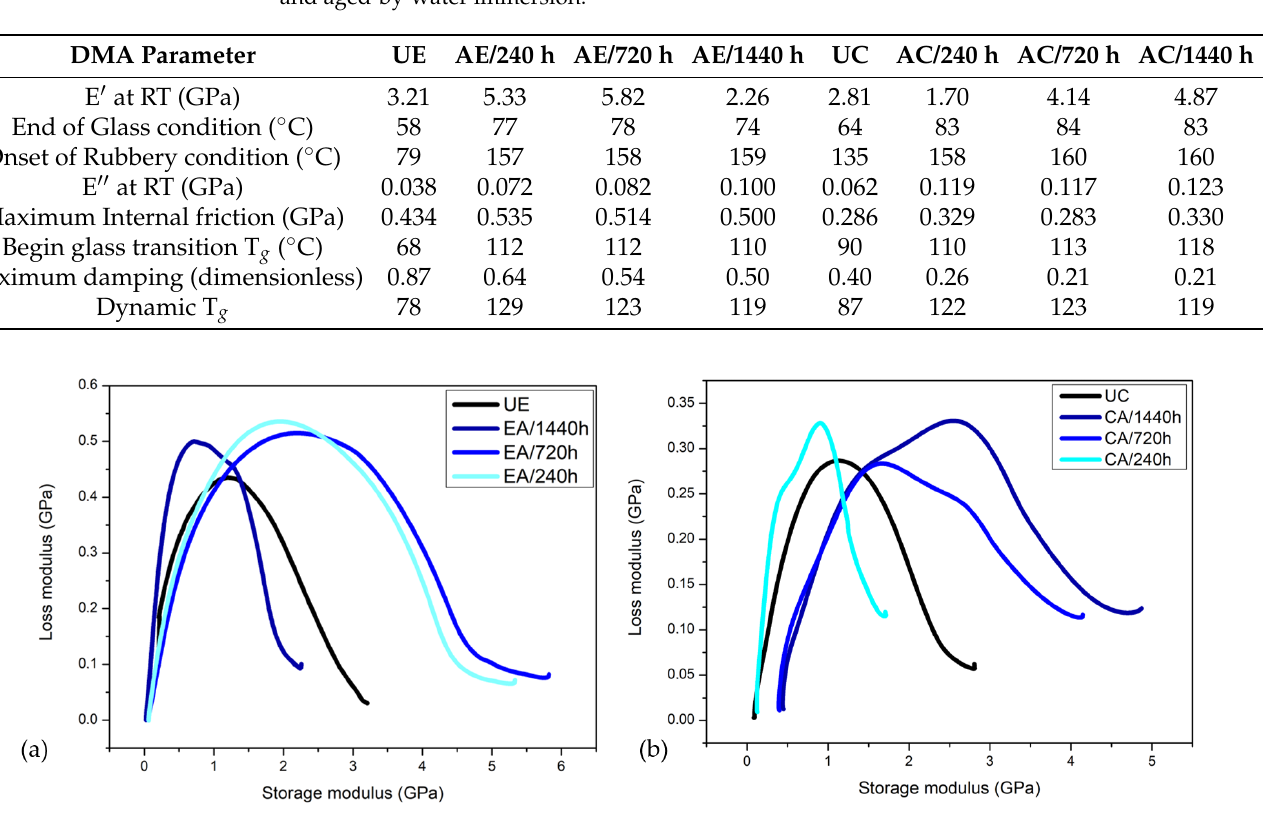
Figure 13. Cole–Cole plots of ( a ) the UE aged epoxy treatments and ( b ) the UC aged composite